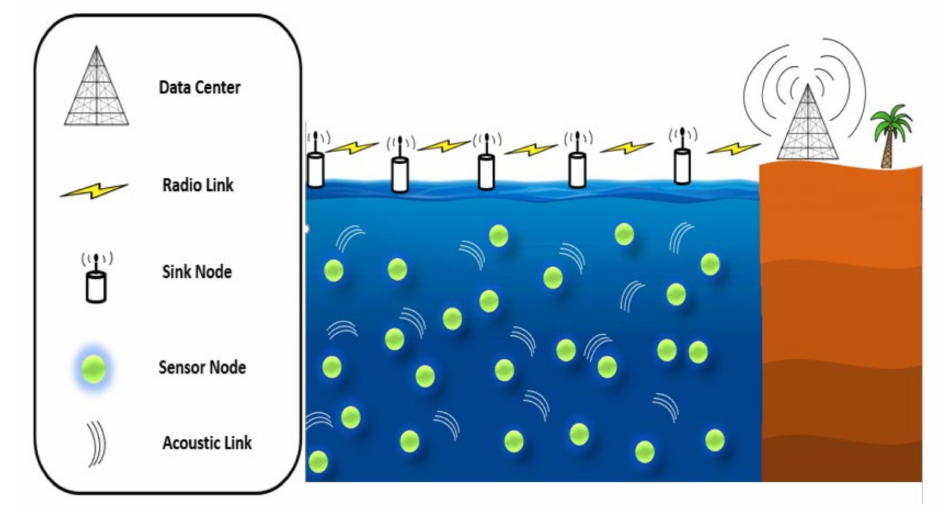
Figure 1. Traditional underwater sensor network